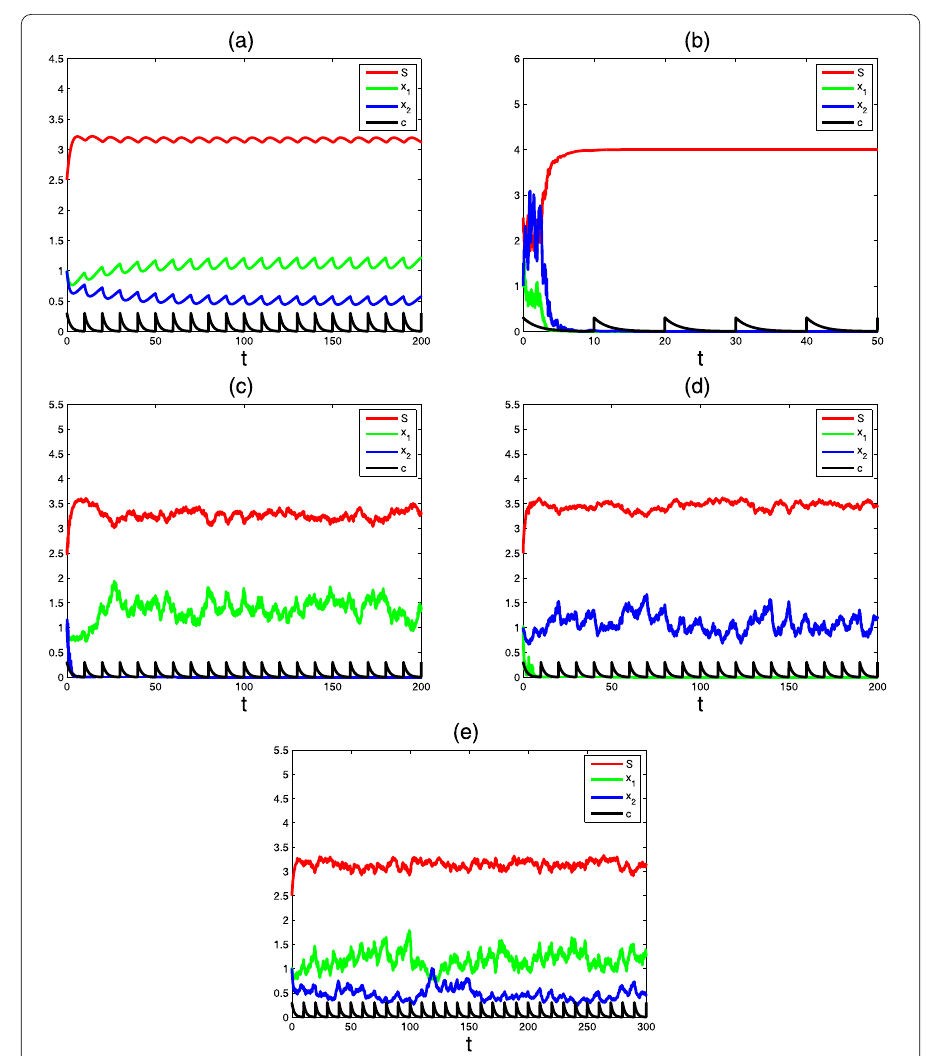
Figure 1 Computer simulation of the paths S ( t ), x 1 ( t ), x 2 ( t ), c ( t ) for the deterministic chemostat model (1) and the stochastic chemostat model (2) with parameters S 0 = 4, Q = 0.5, r 1 = 0.5, r 2 = 0.9, δ 1 = 2, δ 2 = 2.2, a 1 = 15, a 2 = 7.5, μ 1 = 2.7, μ 2 = 1.4, h = 0.5, u = 0.3, τ = 10 and the initial values S (0) = 2.5, x 1 (0) = 1, x 2 (0) = 1, c (0) = 0.3. (a) Time series for S ( t ), X 1 ( t ), X 2 ( t ), c ( t ) with parameters σ 1 = 0, σ 2 = 0. (b) Time series for S ( t ), X 1 ( t ), X 2 ( t ), c ( t ) with parameters σ 1 = 2.4, σ 2 = 1.2. (c) Time series for S ( t ), X 1 ( t ), X 2 ( t ), c ( t ) with parameters